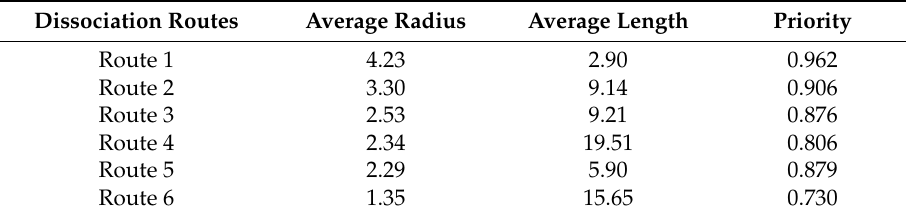
Table 1. Statistical summary of CAVER analysis of TMG-chitotriomycin unbinding from O f Hex1